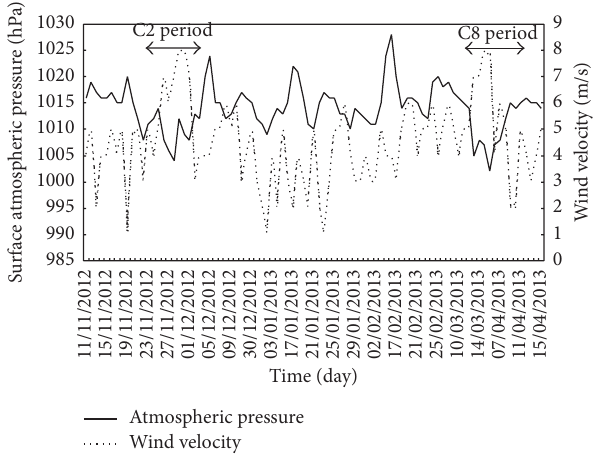
Figure 11: Variations of atmospheric surface pressure and wind speed during the study period.